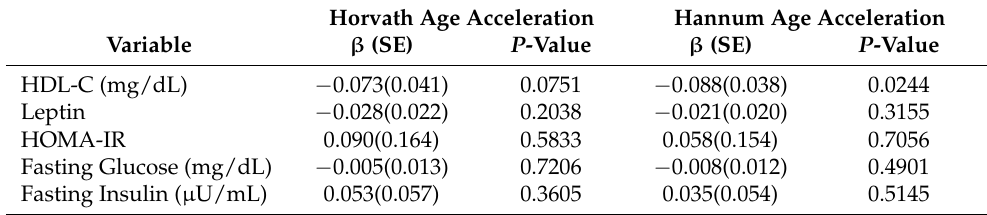
Table 3. Multivariable Linear Regression * of the association between metabolic biomarkers with DNAm age acceleration residual in Mothers (N =